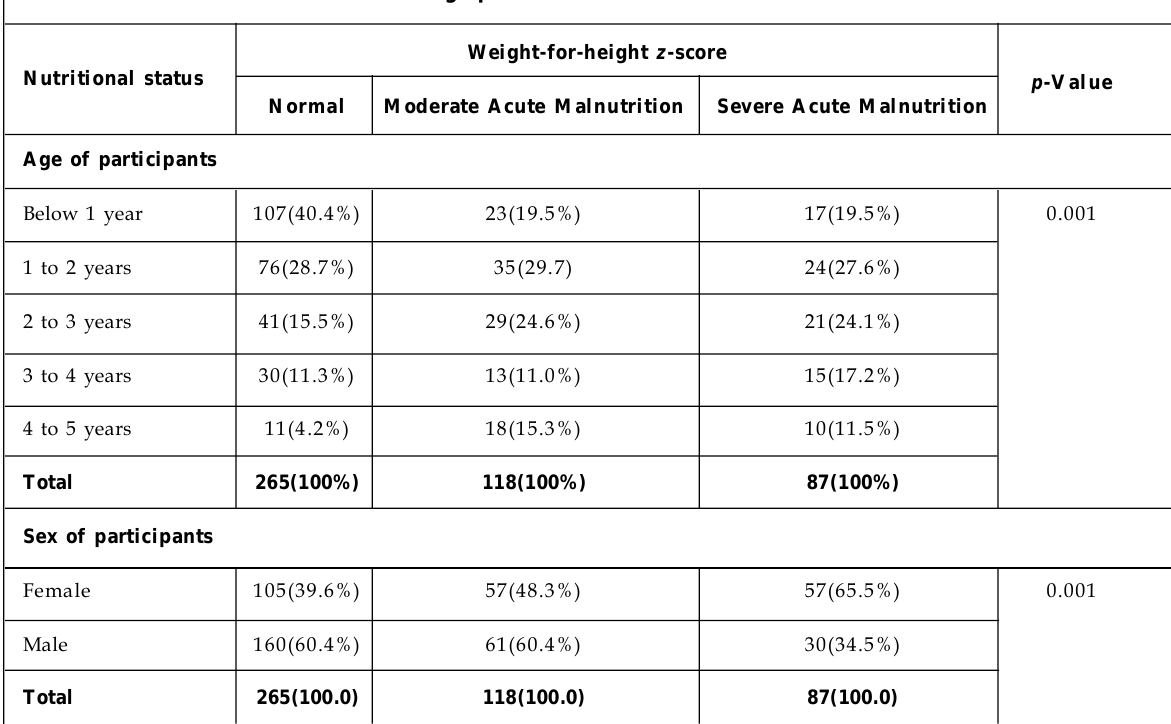
Table 1: Association between sociodemographic factors and nutritional